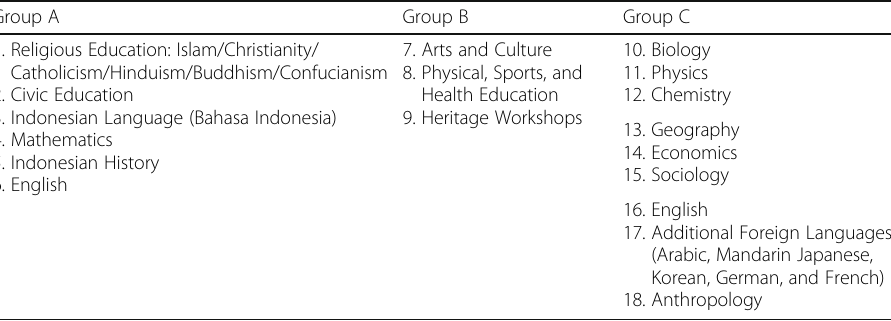
Table 3 List of subjects offered in Indonesian schools Group